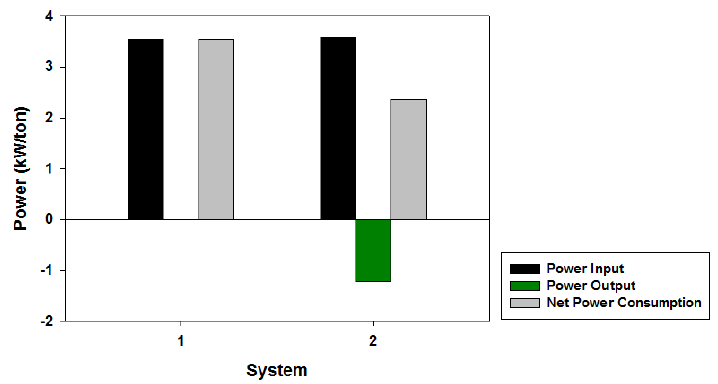
Figure 5. Specific net power consumption of each